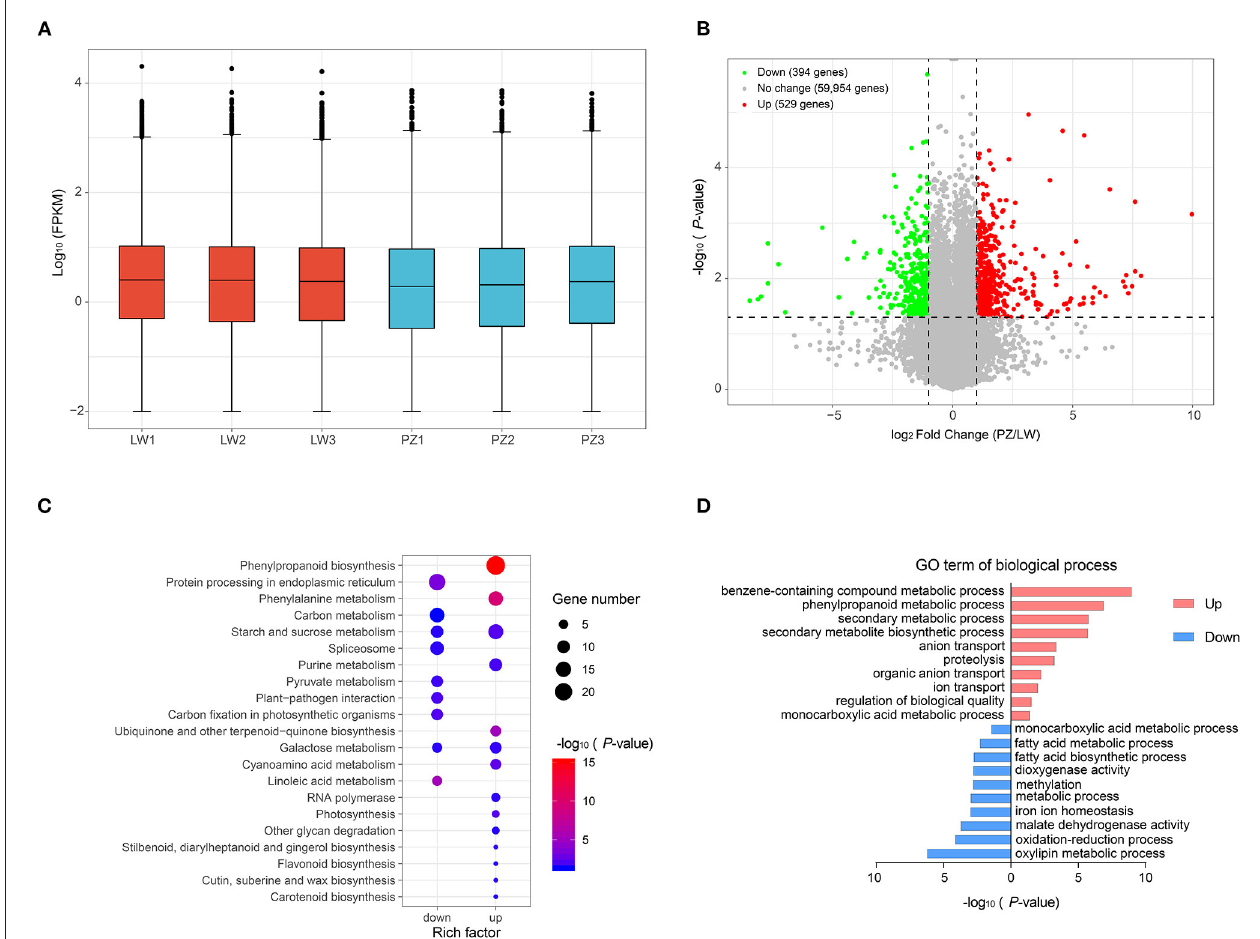
FIGURE 3 | Identification and functional analysis of differentially expression genes (DEGs). (A) Expression level of all genes. (B) Volcano map showed the distribution of all differently expressed genes (DEGs). (C) KEGG pathways significantly enriched ( p -value < 0.05) by up and down-regulated DEGs were shown. (D) The top 10 GO terms (rank by P -value) of biological process were